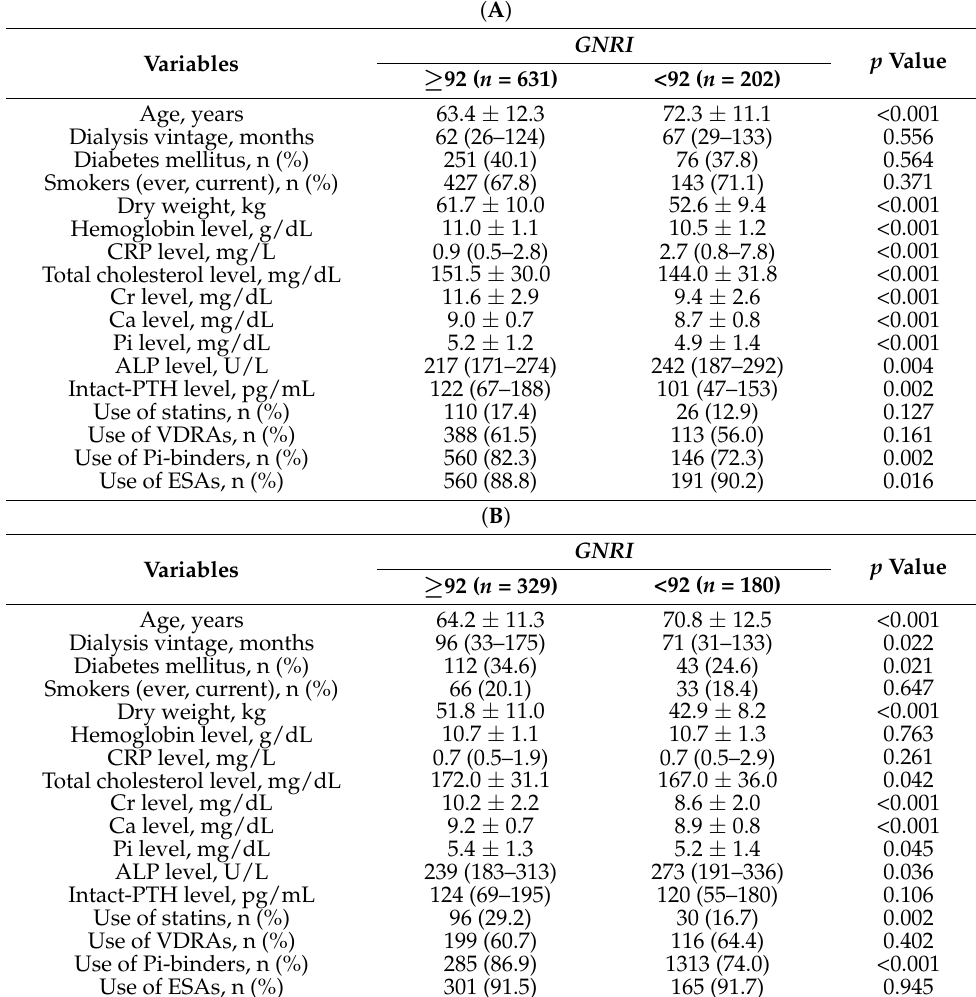
Table 1. Clinical characteristics by GNRI of ( A ) males and ( B )